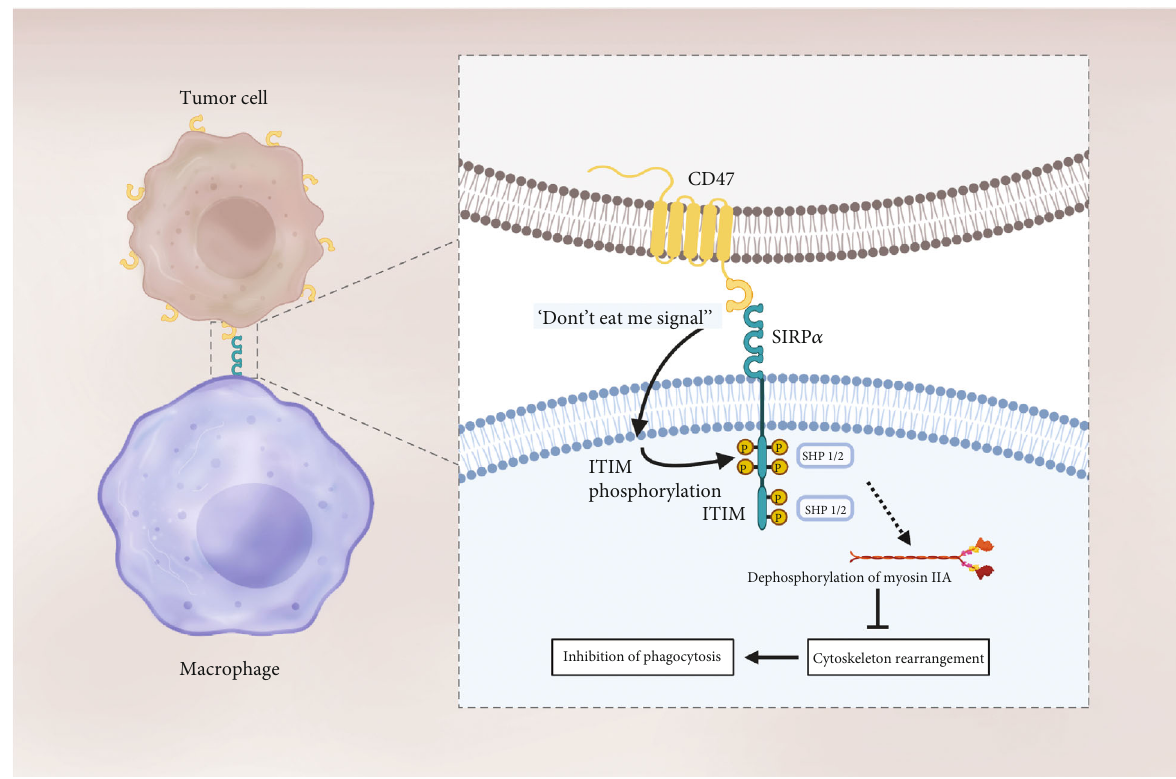
Figure 1: The CD47-SIRP α interaction plays a key role in phagocytosis inhibition. The CD47-SIRP α interaction leads to the phosphorylation of two tyrosine residues in the ITIM motif included in SIRP α ’ s cytosolic domain. Phosphorylation recruits and activates SHP1 & SHP2, signaling a cascade of events that leads to the dephosphorylation of myosin IIA and, therefore, inhibition of the cytoskeleton rearrangement, which is a necessary step for macrophages to engulf target cells. In tumor cells, the enhanced activity of the CD47-SIRP α axis is achieved by increasing CD47